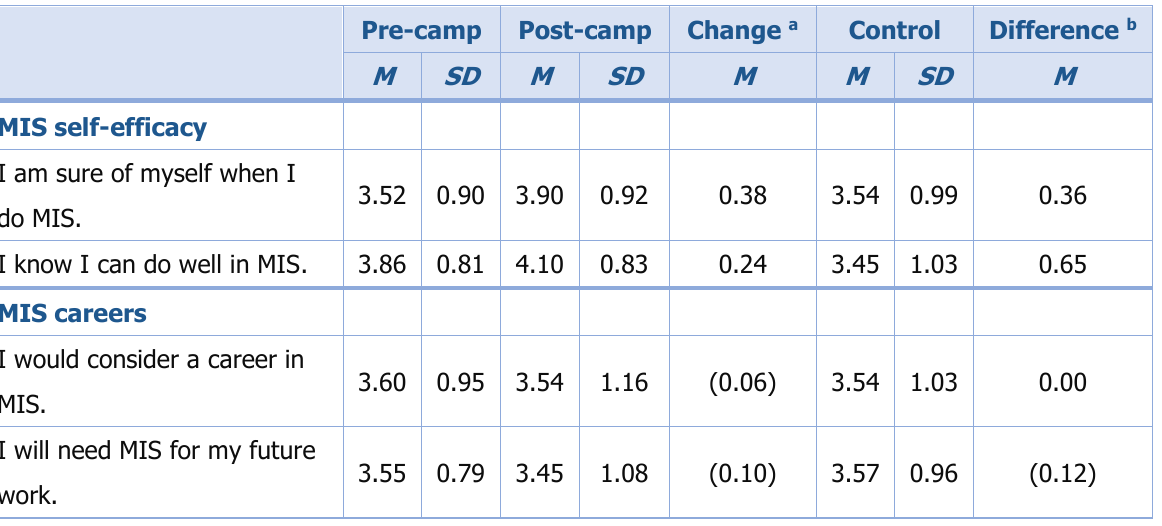
Table 4. Student Attitudes Toward MIS Self-Efficacy and Careers Pre-Camp, Post- Camp, and